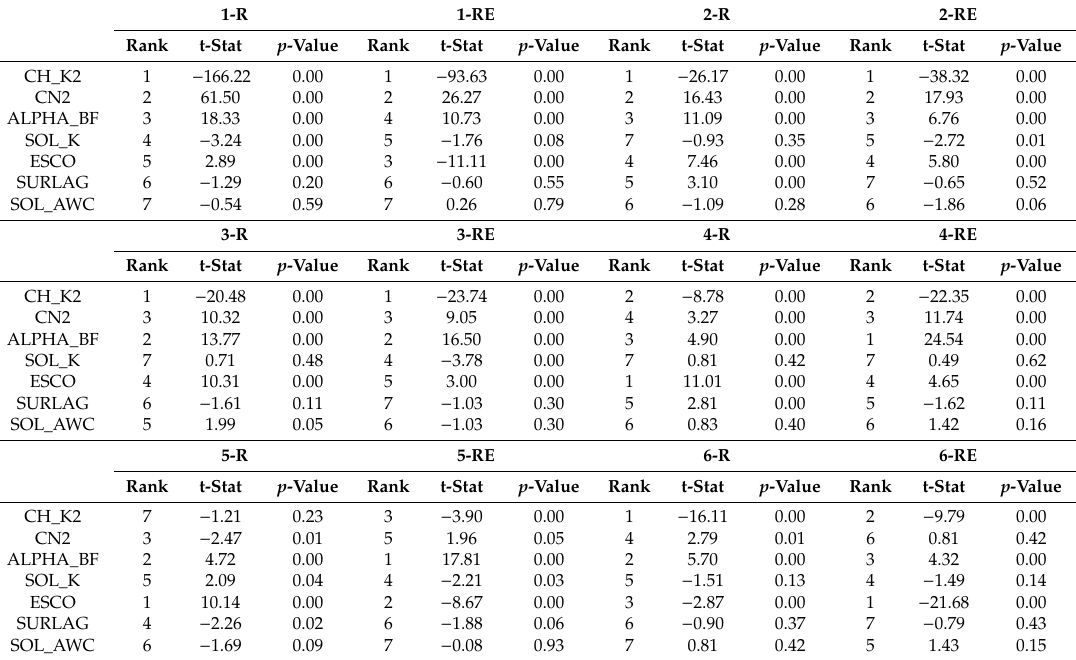
Table 3. Ranks of parameter sensitivity in di ff erent